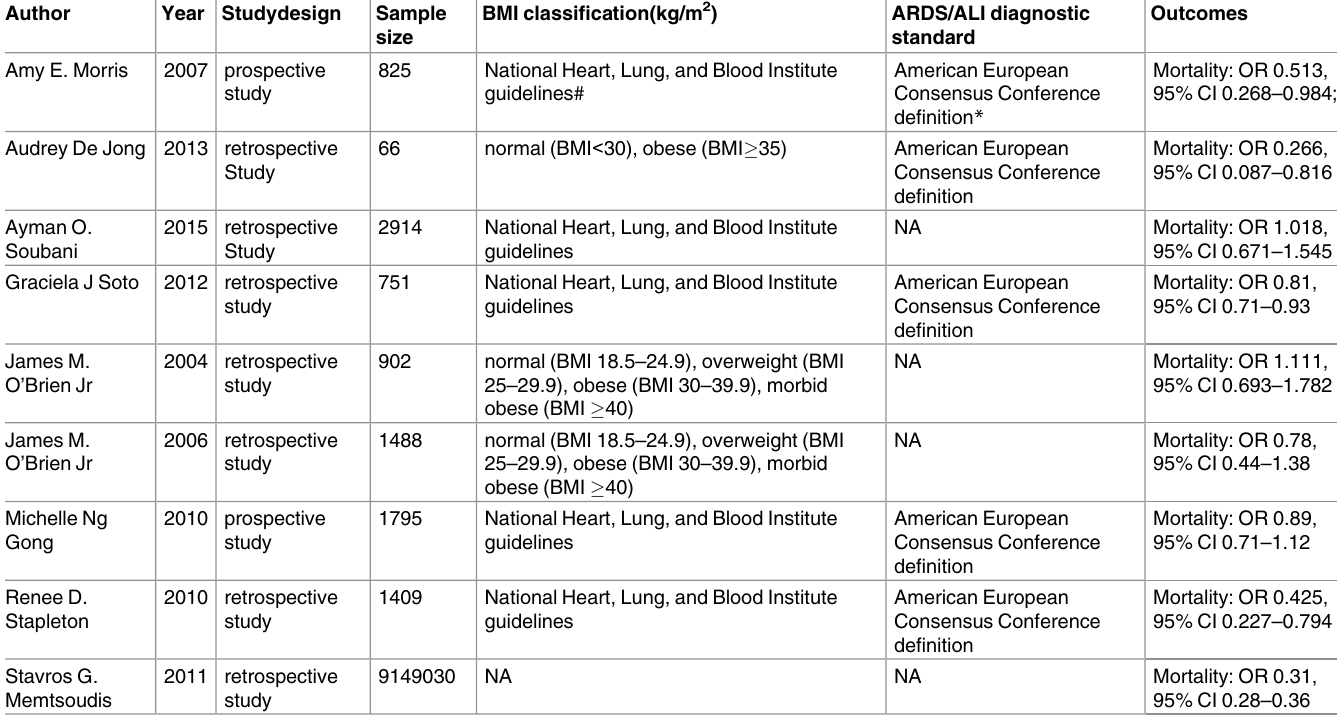
We detected no publication bias among the included studies that assessed obesity in morbidity and mortality of ARDS/ALI based on Egger’s test (P = 0.331,S1 Fig;P = 0.530,S2 Fig). Table 2. Characteristics of included studiesthat examined the effect of obesityonmortality of